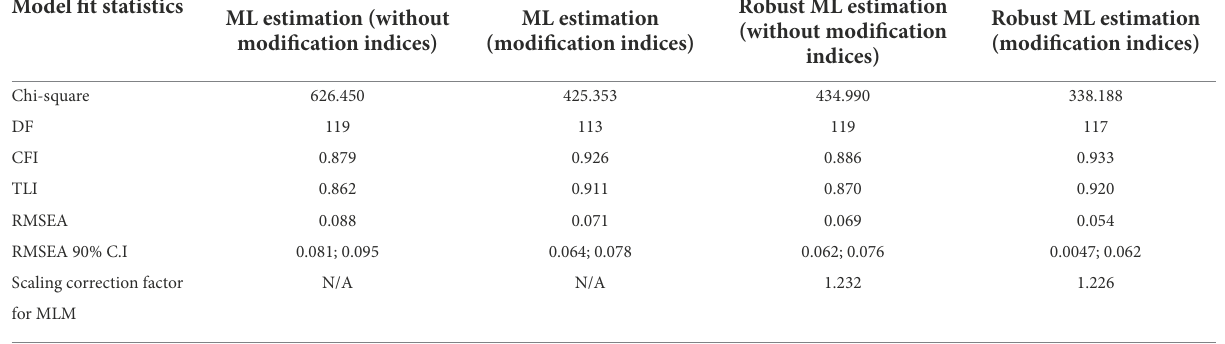
TABLE 3 Comparison of model fit based on maximum likelihood (ML) and robust ML estimation in model 2. Model fit